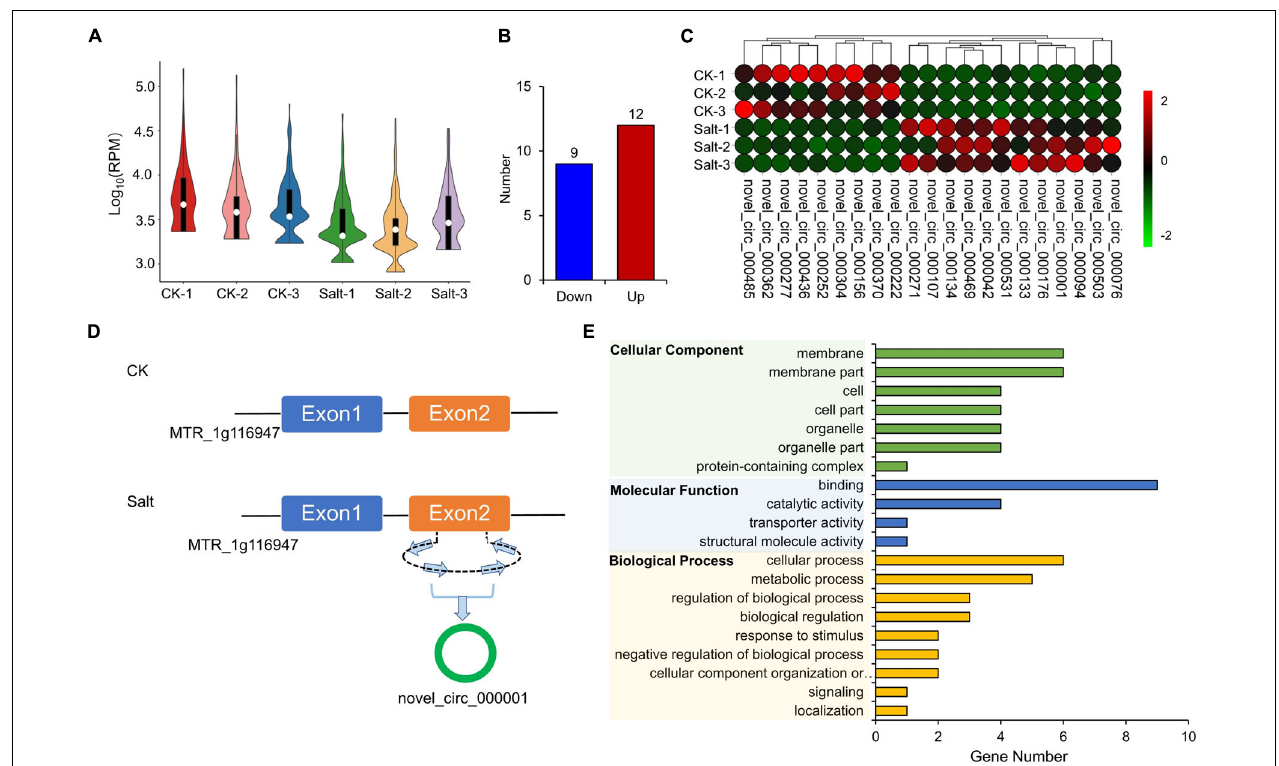
FIGURE 7 | Expression analysis of circRNAs. (A) FPKM distribution of cirsRNAs in six samples. (B) Statistics of down-regulated and up-regulated DEcircRNAs. (C) Expression visualization of DEcircRNAs in six samples. (D) MTR_1g116947 formed novel_circ_000001. (E) GO enrichment of source genes of DEcircRNAs.